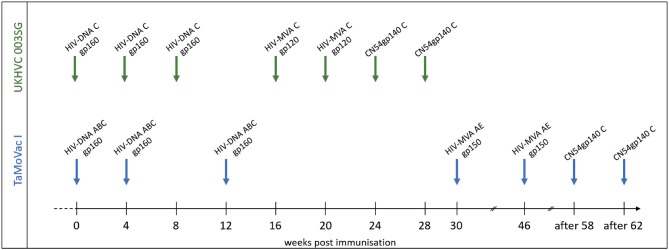
Vaccination schedules in the UKHVC003 Standard Group and TaMoVac01 trial. The UKHVC 003 SG vaccine comprised DNA plasmids (8 mg/immunization) and MVA (108 TCID50/immunization) coding for matched subtype C-derived CN54 based Env and ZM96 Gag, Pol, and Nef immunogen sequences. Of note, MVA-C expressed only the gp120 portion of Env. The CN54rgp140 protein (100 ug/immunization) was adjuvanted with 5ug GLA-AF and administered as two additional boosts. The TaMoVac I vaccination regimen included DNA vaccination (600 or 1,000 μg/immunization) with 7 plasmids (encoding for Env subtypes A, B, and C and Rev subtype B as well as Gag subtypes A, B, and RTmut subtype B) delivered intradermal, followed by MVA-CMDR (108 pfu/immunization), expressing HIV gp150 (subtype E), Gag and Pol (subtype A), and two additional boosts with 100 μg of CN54rgp140 protein adjuvanted with 5 μg GLA-AF.